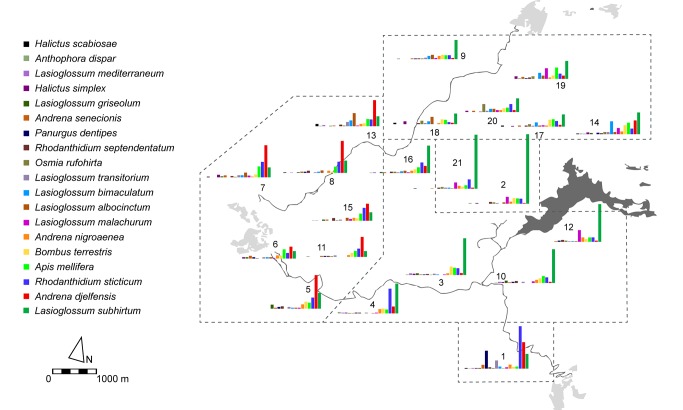
Map of the Garraf Park showing the abundance of the 19 most abundant bee species (representing more than 0.5% of the specimens sampled) in each plot (n = 21).Plots grouped based on bee composition according to cluster analysis.